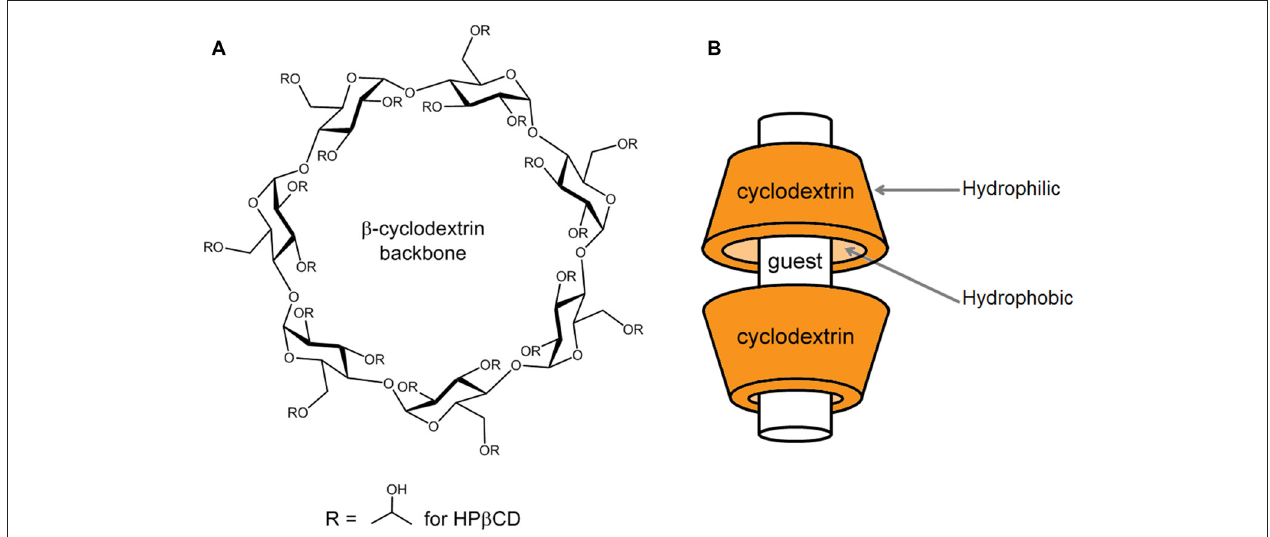
FIGURE 1 | Basic structure of a β -cyclodextrin and mode of complexation with guest compounds. (A) The chemical structure of a β -cyclodextrin backbone is illustrated, depicting the seven glucose units and sites of chemical substitution (R). In the native cyclodextrin, a hydrogen occupies each R site. As an example, in the case of 2-hydroxypropyl- β -cyclodextrin (HP β CD), the R sites are occupied to varying numbers by 2-hydroxypropyl groups, as shown. (B) Guest compounds can incorporate into the hydrophobic interior of the toroidal cyclodextrin molecule, where they are protected from water. The drawing is modeled after the interaction of HP β CD with cholesterol, where HP β CD dimers can encapsulate one cholesterol molecule (López et al., 2011, 2013).